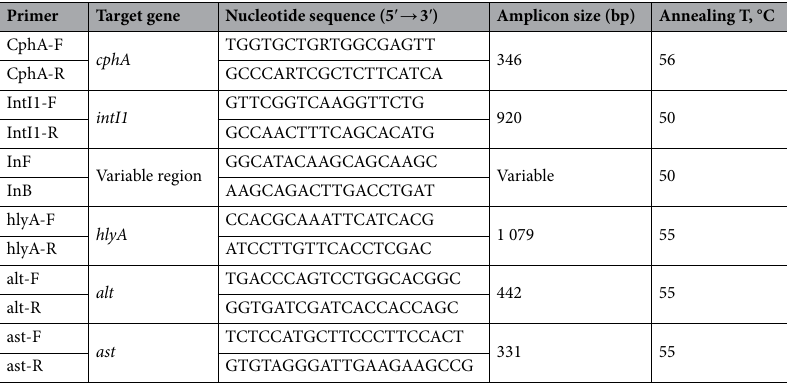
Table 3. Primers used for PCR